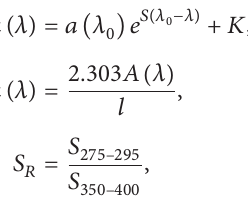
Table 2: Basic physical properties of the soil samples. Sample point Clay (%)